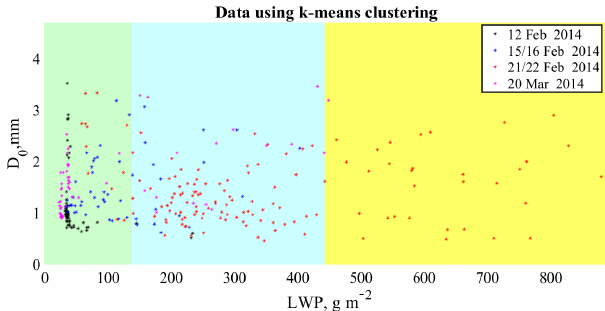
Figure 3. Plot of median diameter D 0 with respect to LWP for the three cluster regions, LR, MR and HR, (green, cyan, yellow) ob- tained on four snowfall days of BAECC IOP campaign. Black, blue, red and magenta points respectively represent the data for 12, 15/16, 21/22 February and 20 March 2014. The k -means clustering high- lights the weak dependence of the classes from D 0 .